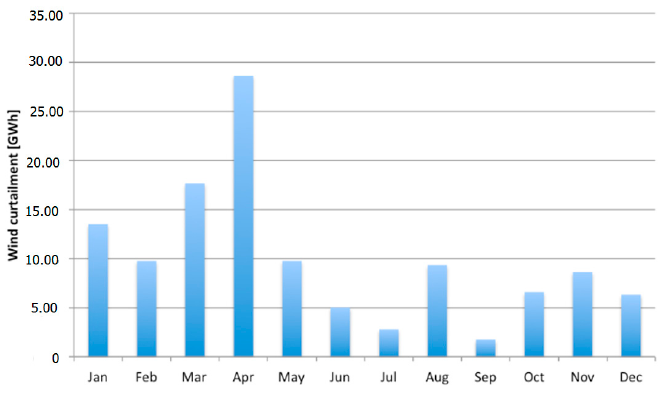
Figure 11. Monthly values of wind curtailment, resulting from the simulation.